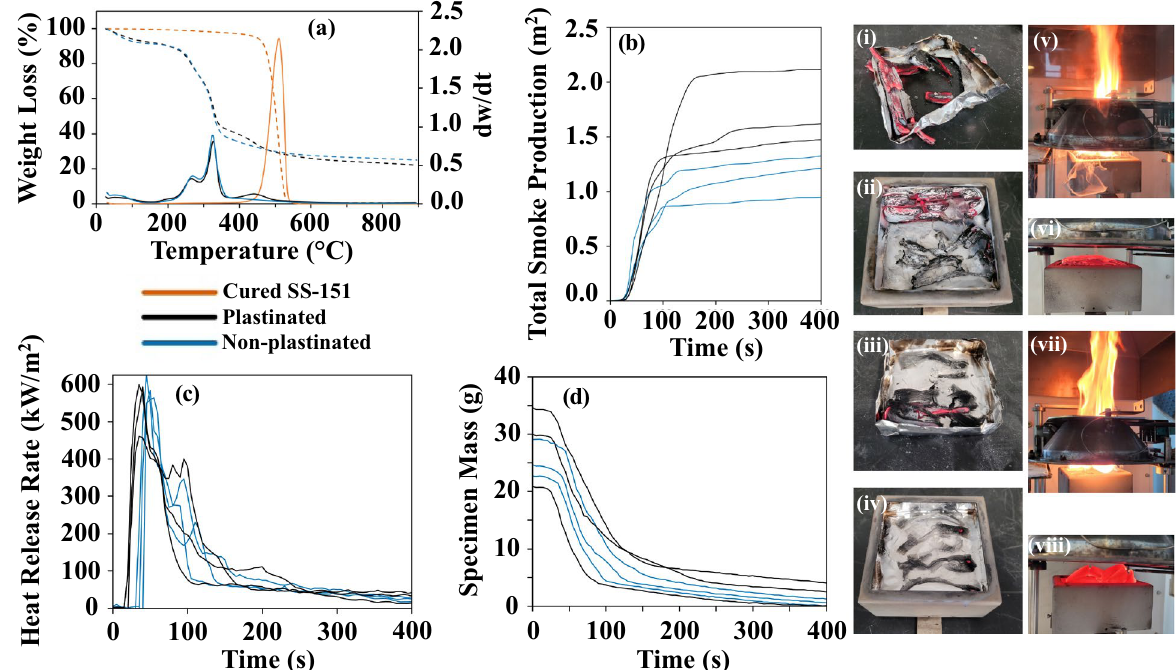
Figure 8. ( a ) TGA results of cured pure SS-151, plastinated bamboo, and non-plastinated bamboo. ( b ) TSP, ( c ) HRR, and ( d ) specimen mass from the cone calorimetry test (each repeated three times). (i-ii) Two of the plastinated bamboo specimens after the cone calorimetry test. (iii-iv) Two of the non-plastinated bamboo specimens after the cone calorimetry test. Large flame present after ignition for one of the (v) plastinated and (vii) non-plastinated specimens. (vi) Plastinated and (viii) non-plastinated bamboo specimens gradually burning until the end of the test.